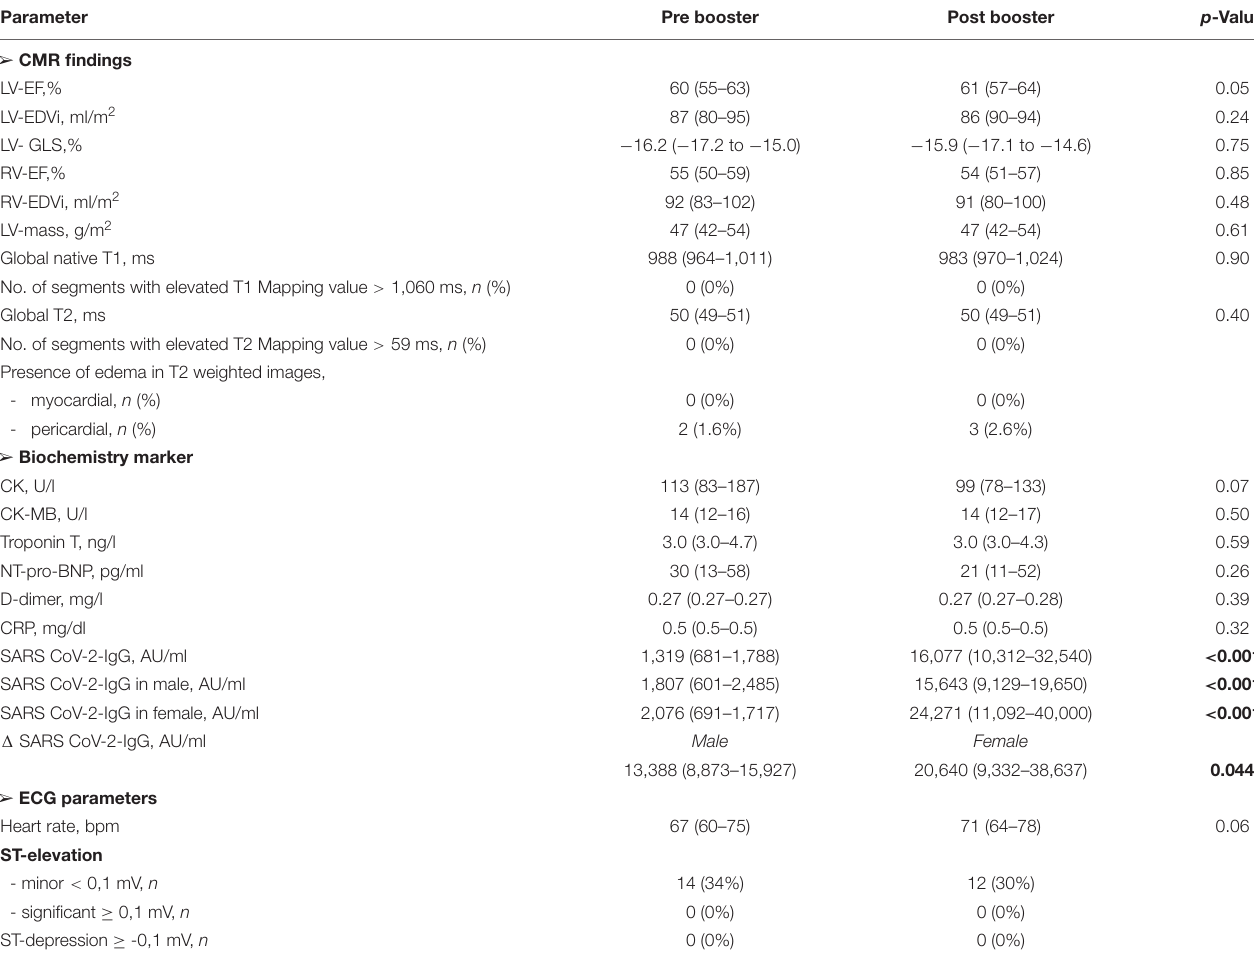
TABLE 2 | Cardiac magnetic resonance (CMR)-findings, laboratory, and ECG parameters. Parameter Pre